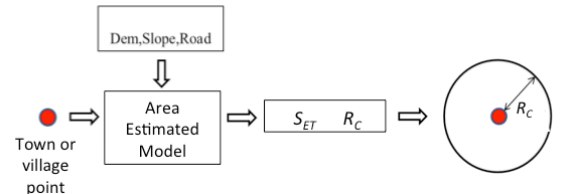
Figure 2. Updating procedure in the region without original residential area